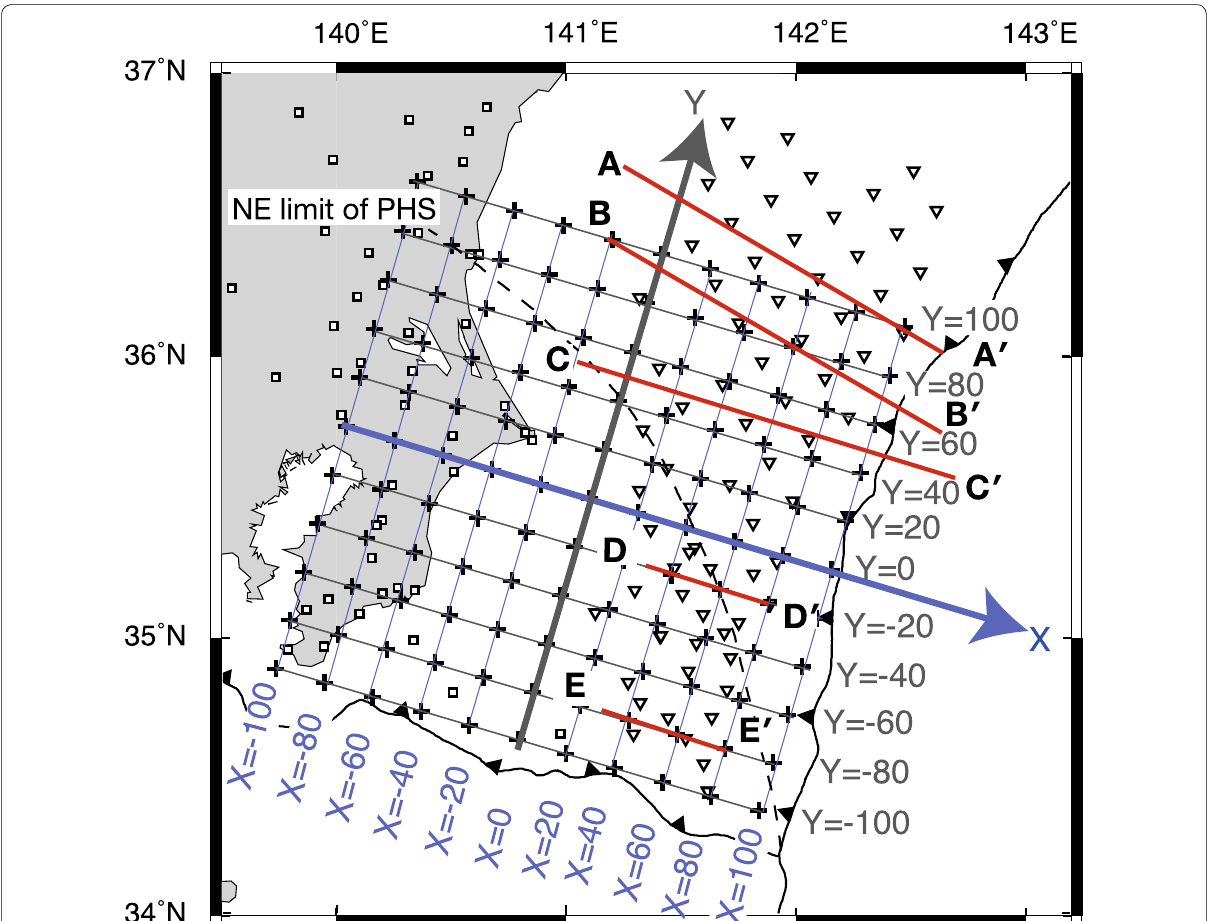
Fig. 4 Configuration of the grid nodes during the tomographic inversions and the projected lines for the stacked RF images. The crosses represent the locations of velocity nodes in the horizontal section. The triangles and squares indicate stations. Lines A–A ′ , B–B ′ , C–C ′ , D–D ′ , and E–E ′ define the locations of the depth-domain